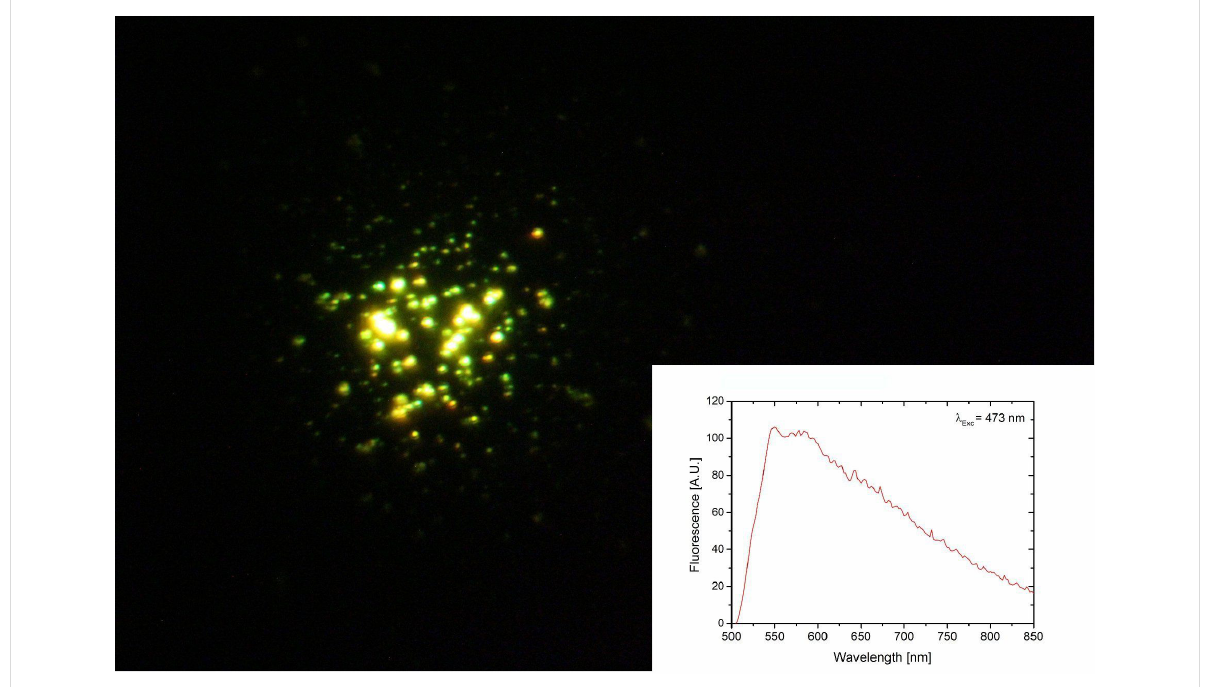
Figure 6: Image and spectrum of multicolor luminescence collected from green silver nanoparticles. The plasmonic silver particles were excited using 473 nm light provided by a 20 mW laser diode through a 100× oil immersion objective. The illuminated spot is around 10 µm 2 .